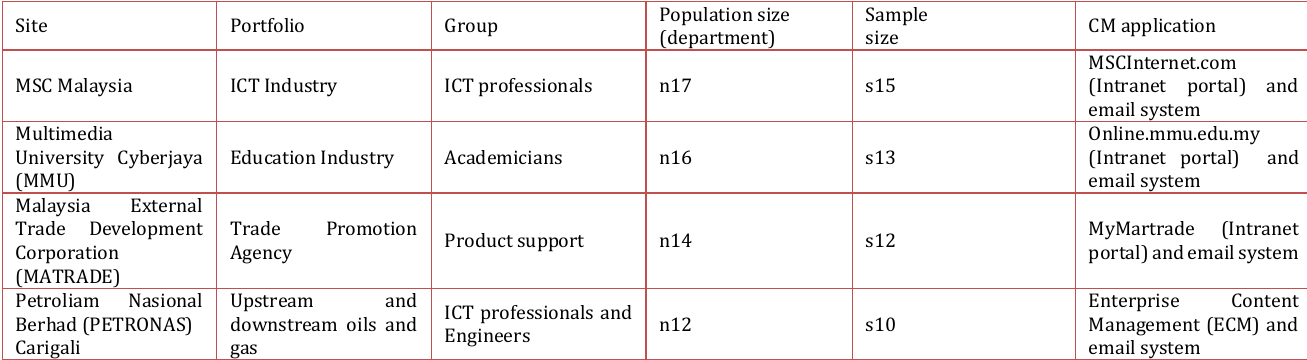
Table 1: Site and population sampling